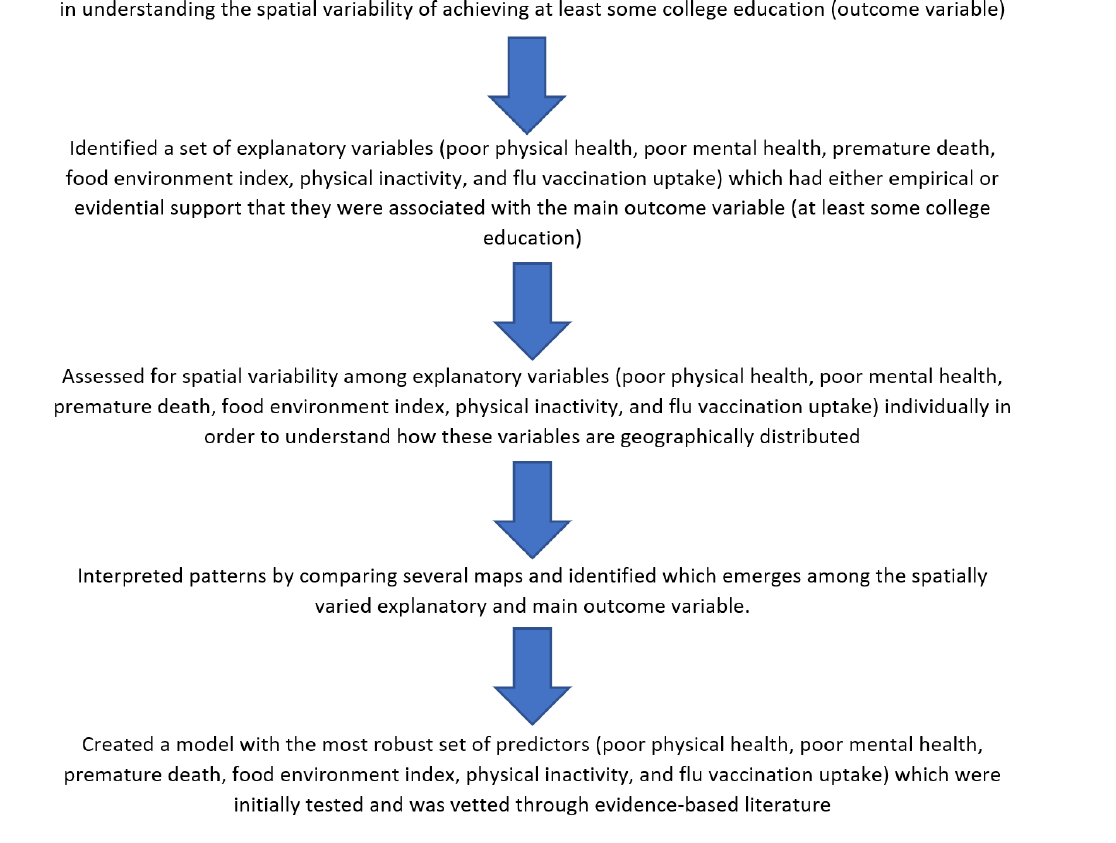
Figure 3. Detailed Geospatial Workflow